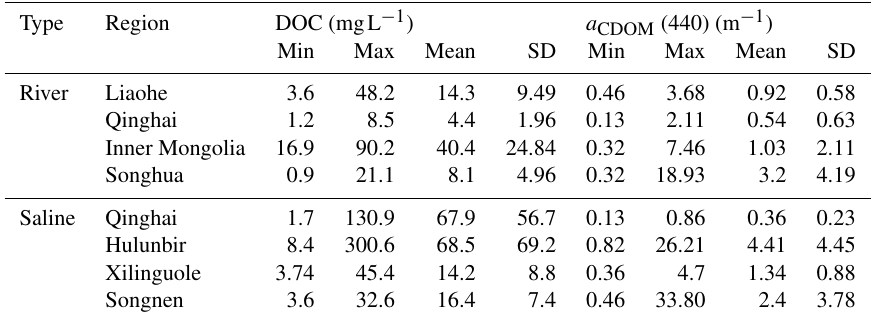
Table 2. Descriptive statistics of dissolved organic carbon (DOC) and a CDOM (440) in various types of waters. Min, minimum; Max, maximum; and SD, standard deviation.